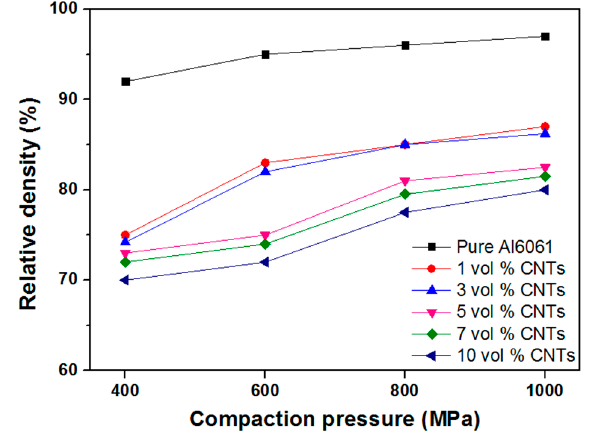
Figure 2. Relative density according to compaction pressure.